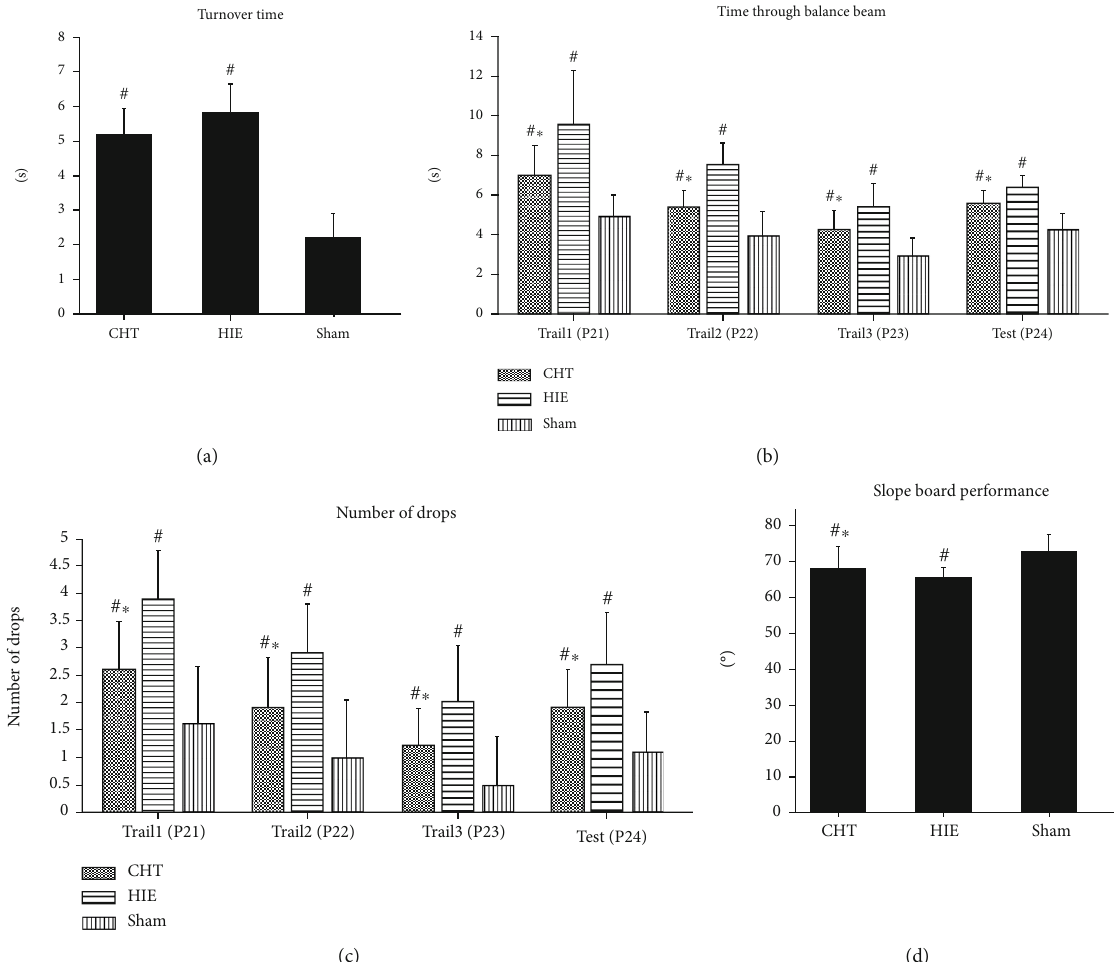
Figure 2: Chinese Tuina improved behavioral recovery in rats with HIE. ∗ P < 0 : 05 , comparison with the HIE group, # P < 0 : 05 : comparison with the sham group, n = 10